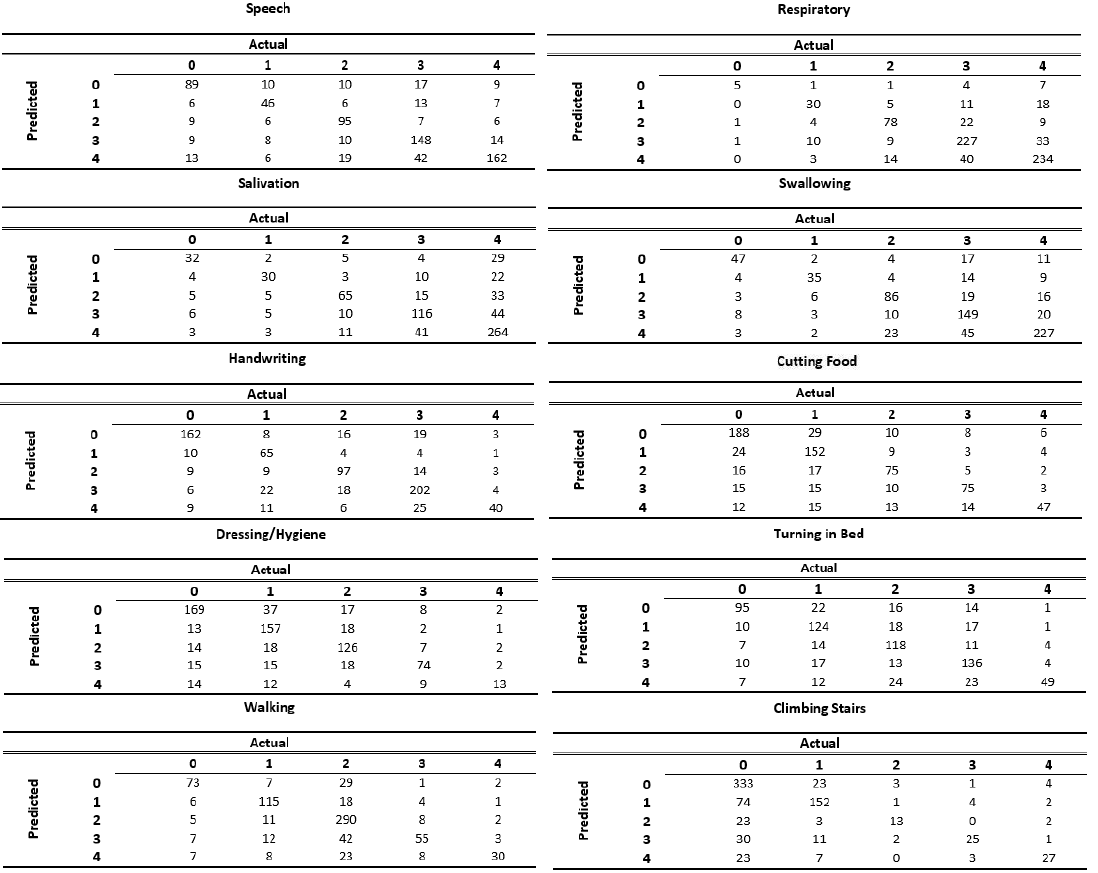
Figure 4. Confusion matrices for each of the ALSFRS items when predicting disease state using only information from the first clinic